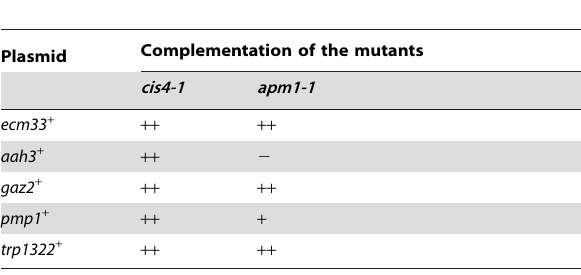
Table 1. Complementation of the MgCl 2 -sensitive phenotype of the cis4-1 mutant and apm1-1 mutant.